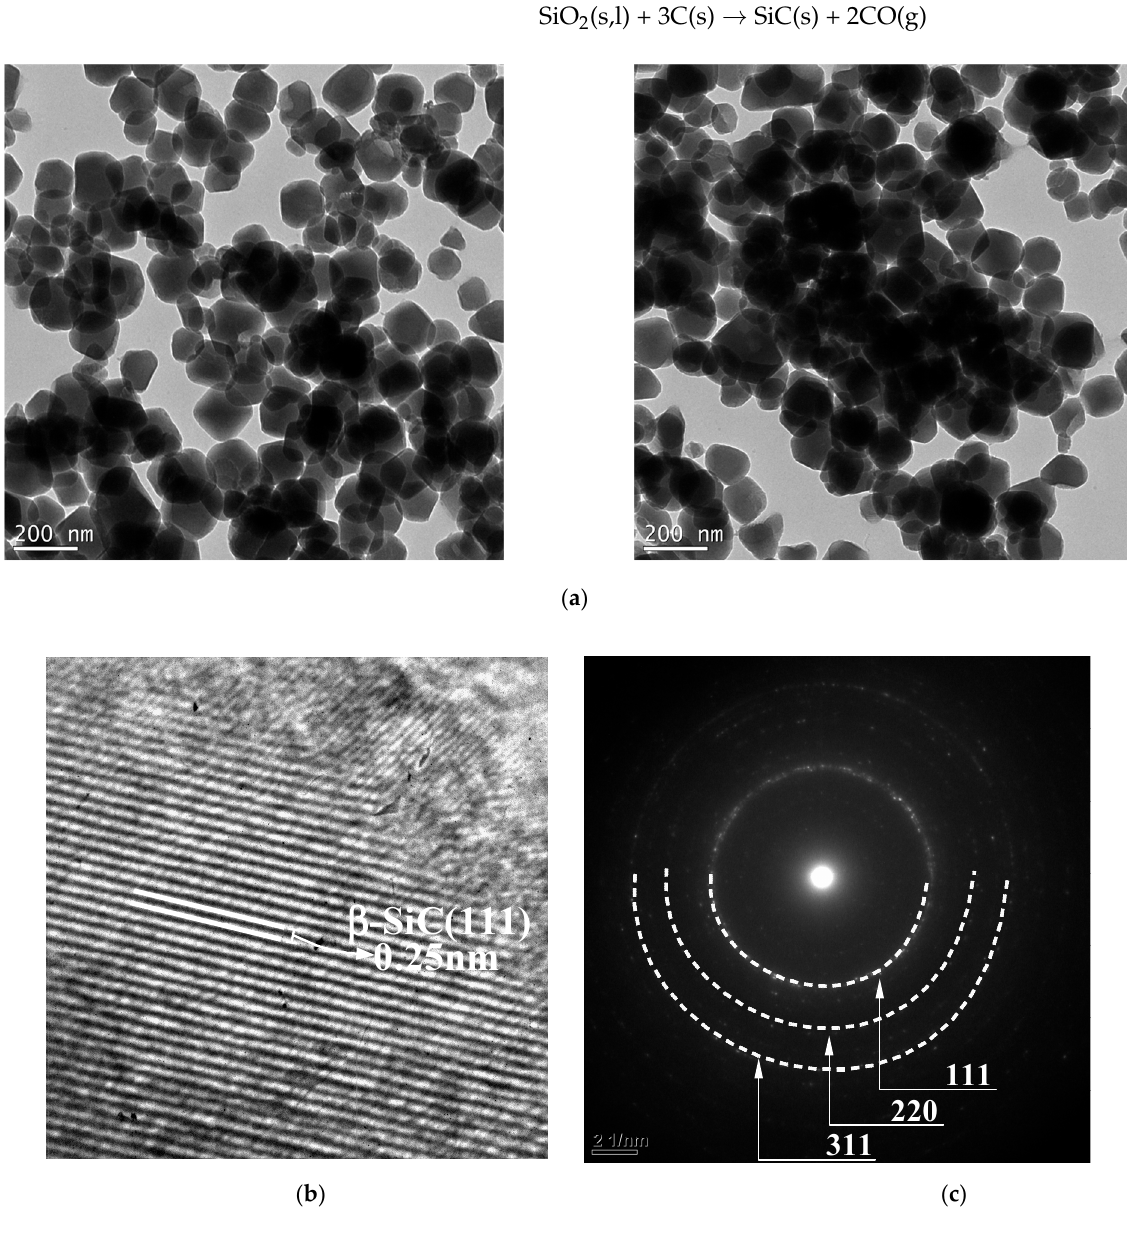
Figure 9. ( a ) A general low-resolution TEM image, ( b ) a representative high-resolution, ( c ) a corresponding selected area electron diffraction pattern of SiC nanoparticles obtained at 1500 °C for 2 h.